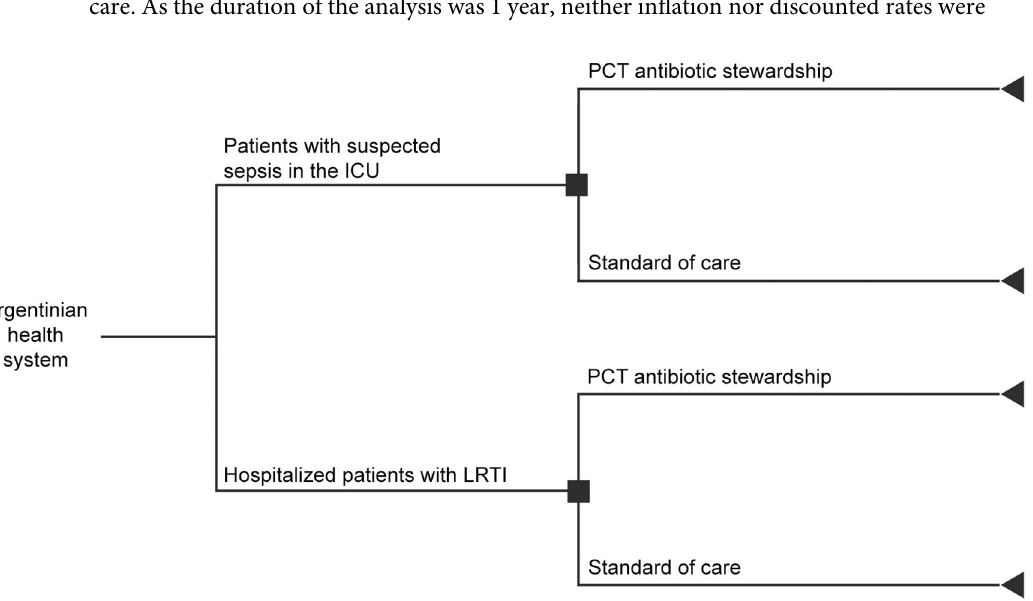
Fig 1. Model structure. Decision tree adapted for Argentina. ICU, intensive care unit; LRTI, lower respiratory tract infection; PCT, procalcitonin. Adapted from Mewes JC, Pulia MS, Mansour MK, Broyles MR, Nguyen HB, Steuten LM. The cost impact of PCT- guided antibiotic stewardship versus usual care for hospitalized patients with suspected sepsis or lower respiratory tract infections in the US: a health economic model analysis. PLOS One. 2019; 14(4):e0214222 [26].